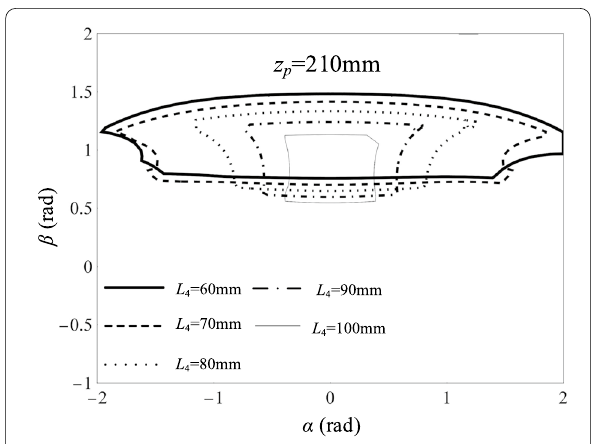
Figure 18 The image of the singular position of the mechanism 210 mm when z p =